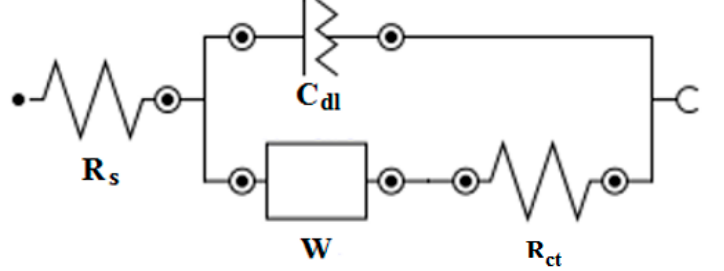
Figure 4. Equivalent electrical circuit model where R s —electrical resistance of electrolyte, C dl — electrical double layer, R ct —the resistance of the electrical transfer charge, W—Warburg impedance. R s —shows electrolyte resistance, C dl —capacity of electric double layer or known as element constant phase which shows the behavior of a non-ideal interface of metal- electrolyte capacity, whereas W shows the Warburg impedance and R ct shows the charge transfer resistance of the interface. lent circuit provided in Figure 4.